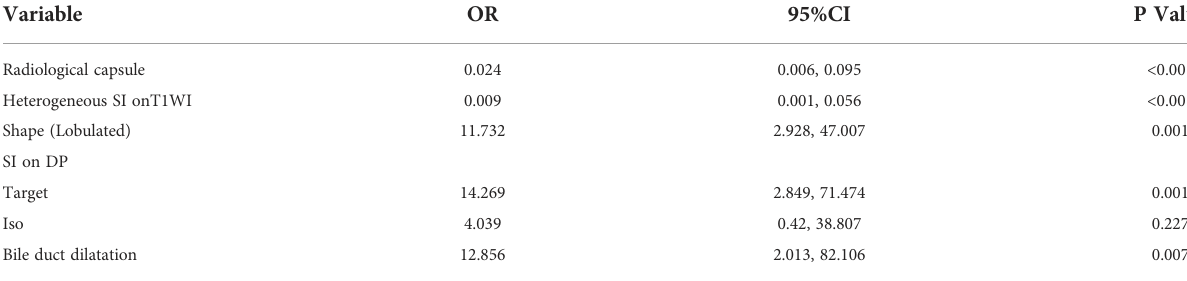
TABLE 4 Multivariate analysis for distinguishing HCCs and